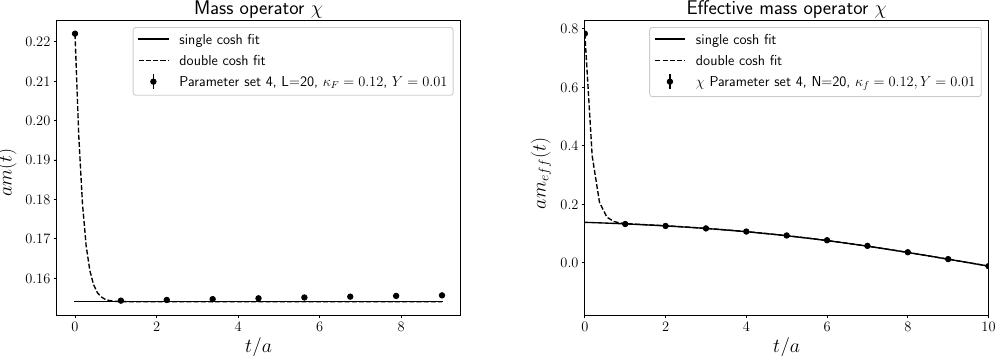
Figure 1: Example of the effective mass from the gauge-invariant propagator of the χ fermion for system 4 on a 20 4 lattice at κ = 0.12 and Y = 0.01. The fit stems from F a two-cosh fit, of which the lighter is also shown alone to emphasize its dominance at long times. Errors are smaller than the symbol size. The top-panel shows the effective mass as defined in (24), while the lower panel shows the effective mass as defined in (27). Note the different scale in both